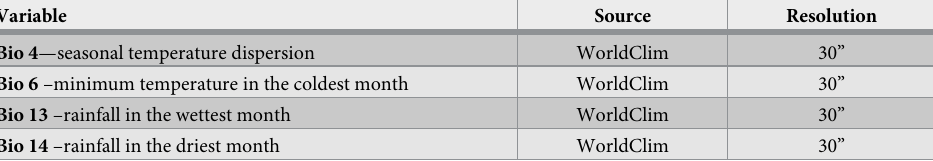
Table 1. List of the environmental variables selected to implement the MaxEnt species distribution models for G . bermejoi